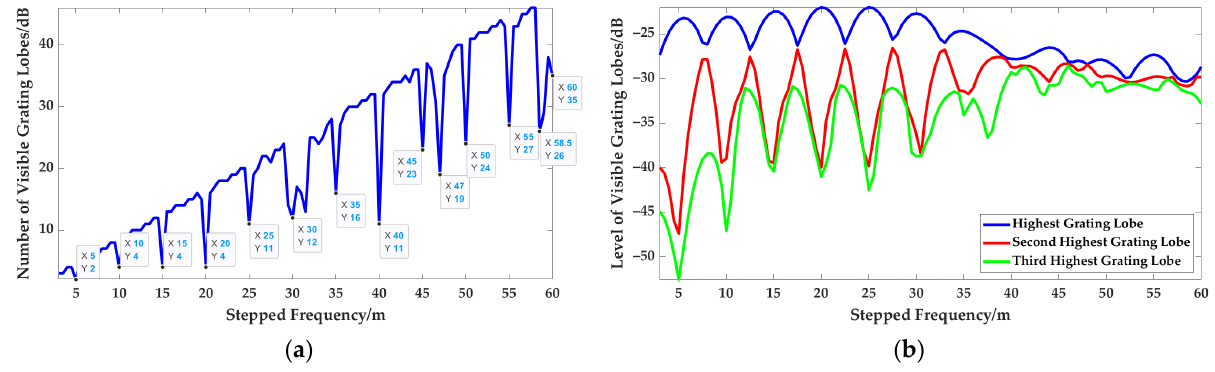
Figure 12. Simulation results of the effect of step frequency on visible grating lobes: ( a ) relationship between the number of the visible grating lobes and step frequency; ( b ) relationship between the levels of the visible grating lobes and step frequency.